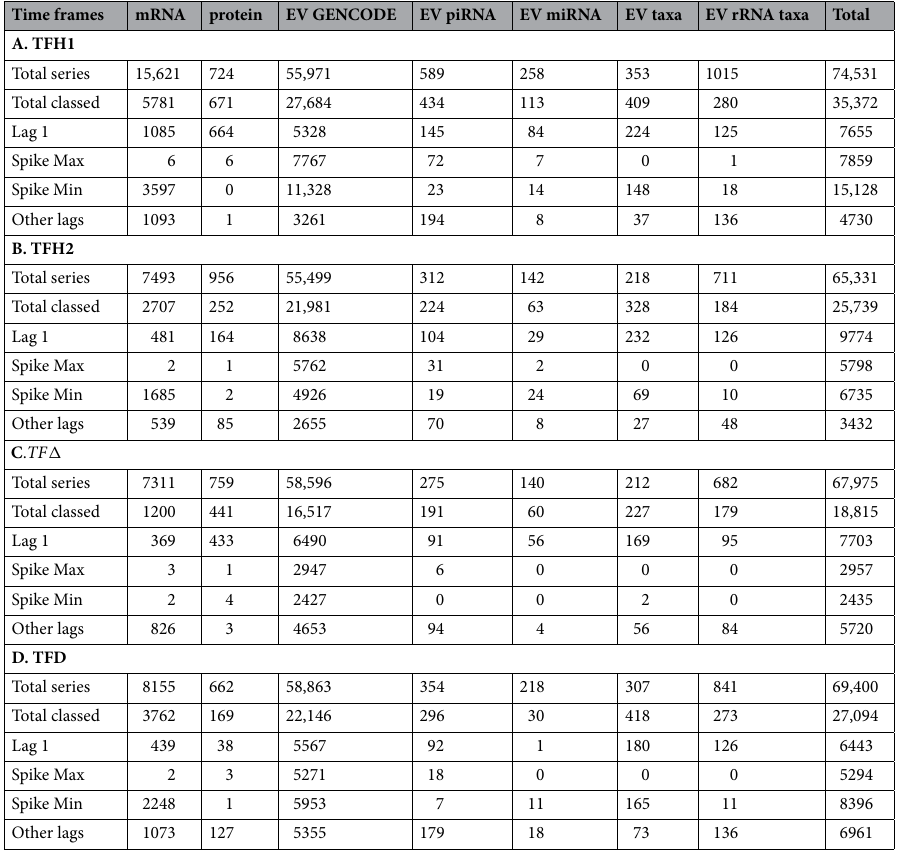
Table 1. Time series counts and classifications across saliva omics for the various time